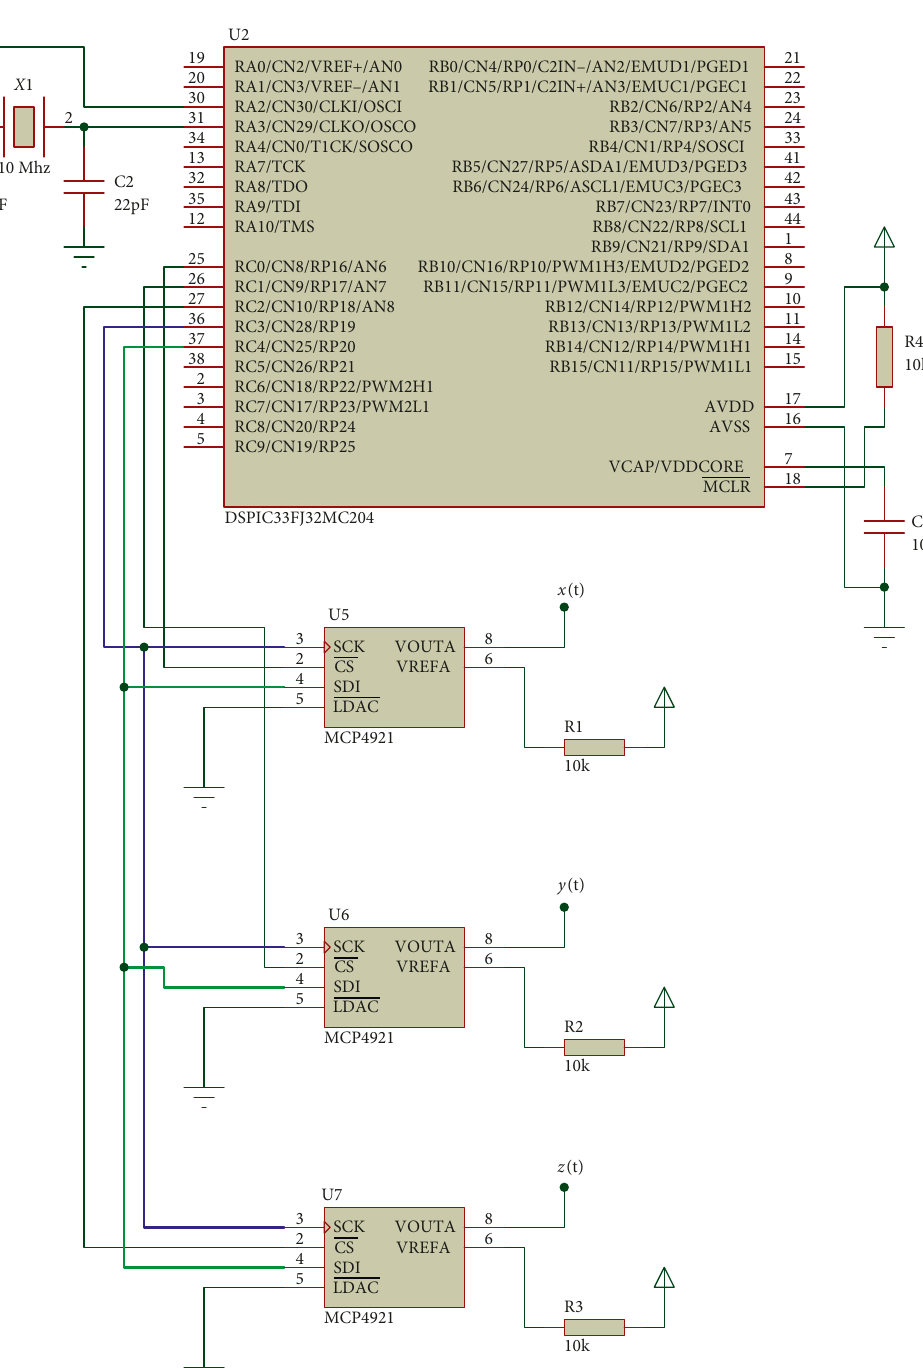
Figure 9: Schematic of the simulation of ES in V2 by using